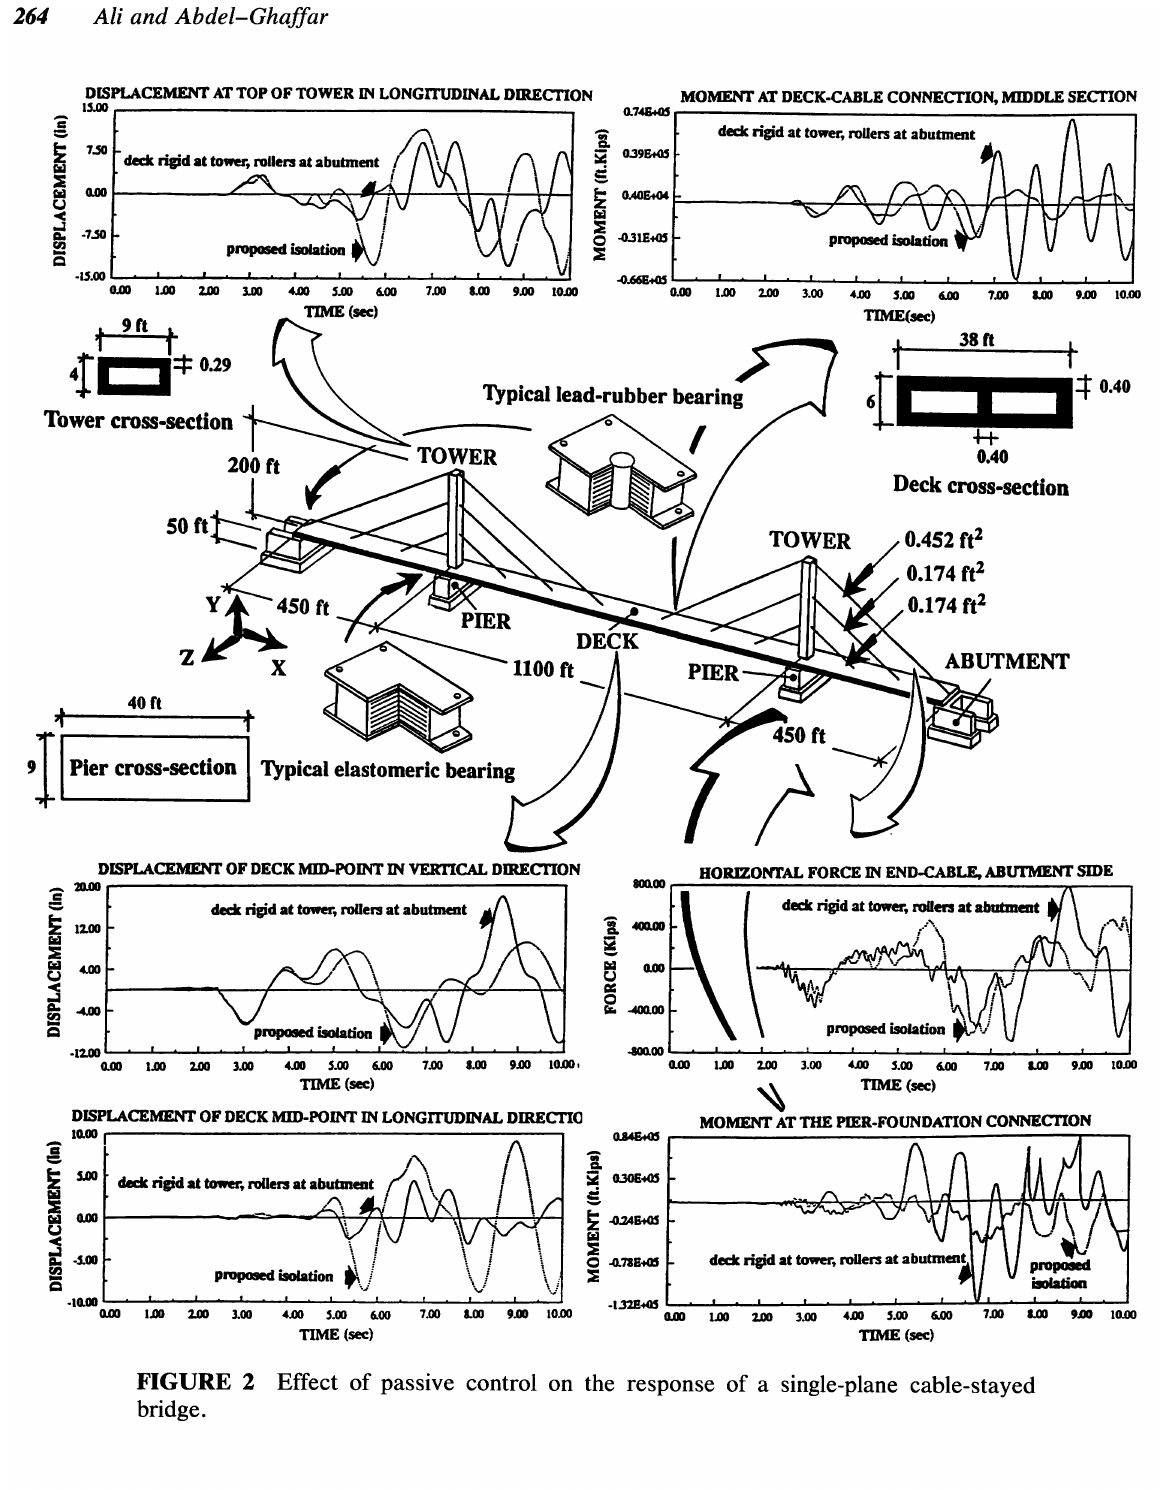
FIGURE 2 Effect of passive control on the response of a single-plane cable-stayed